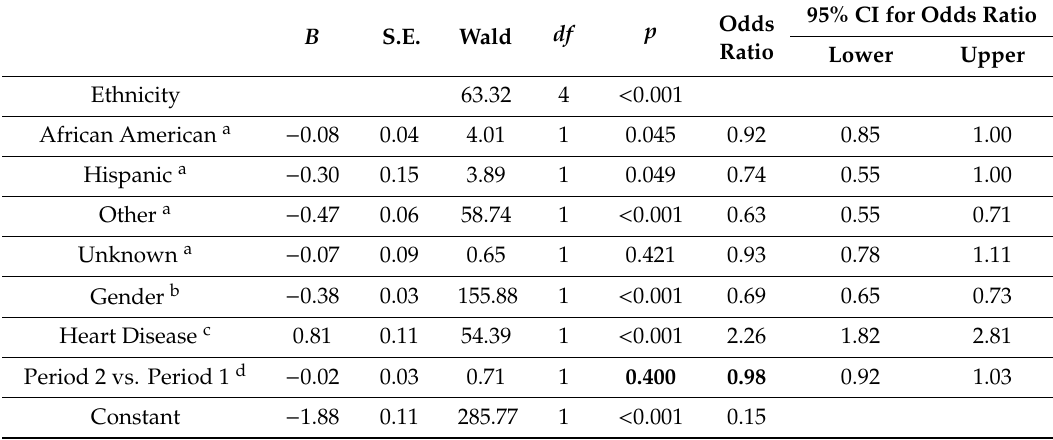
Table 1. Odds of performing coronary artery bypass grafting (CABG) versus percutaneous coronary intervention (PCI) in period 2 compared with period 1, controlling for covariates. 95% CI for Odds Ratio Odds B S.E. Wald df p Ratio Lower Upper Ethnicity 63.32 4 < 0.001 African American a − 0.08 0.04 4.01 1 0.045 0.92 0.85 1.00 Hispanic a − 0.30 0.15 3.89 1 0.049 0.74 0.55 1.00 Other a − 0.47 0.06 58.74 1 < 0.001 0.63 0.55 0.71 Unknown a − 0.07 0.09 0.65 1 0.421 0.93 0.78 1.11 Gender b − 0.38 0.03 155.88 1 < 0.001 0.69 0.65 0.73 Heart Disease c 0.81 0.11 54.39 1 < 0.001 2.26 1.82 2.81 Period 2 vs. Period 1 d − 0.02 0.03 0.71 1 0.400 0.98 0.92 1.03 Constant − 1.88 0.11 285.77 1 < 0.001